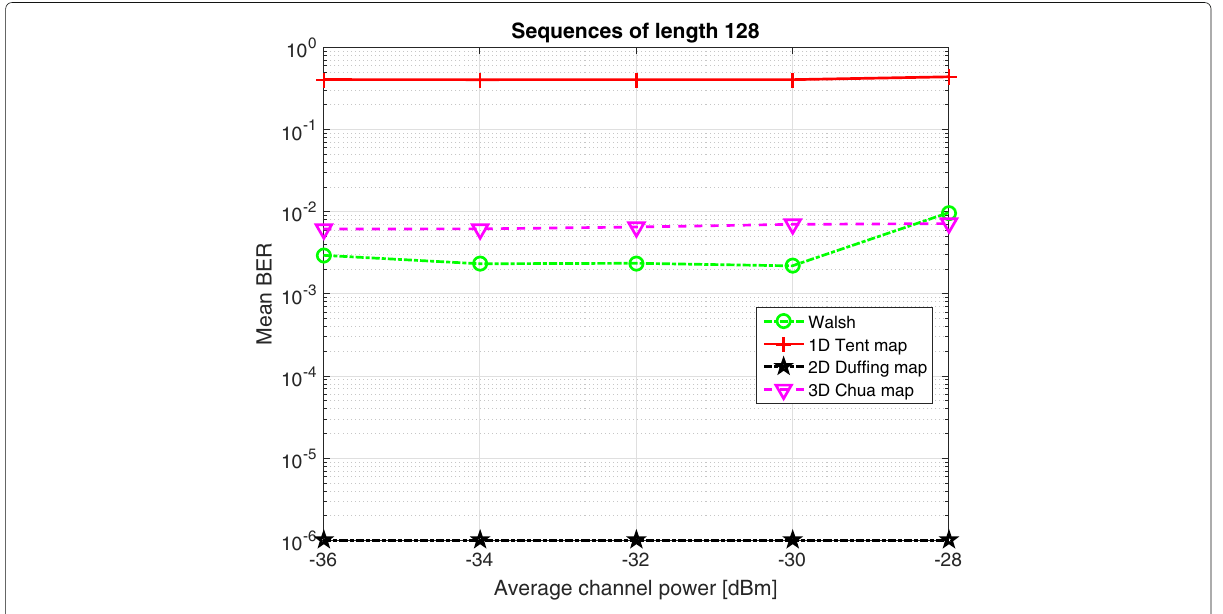
Fig. 10 Mean BER against against average channel power for sequences of length 128